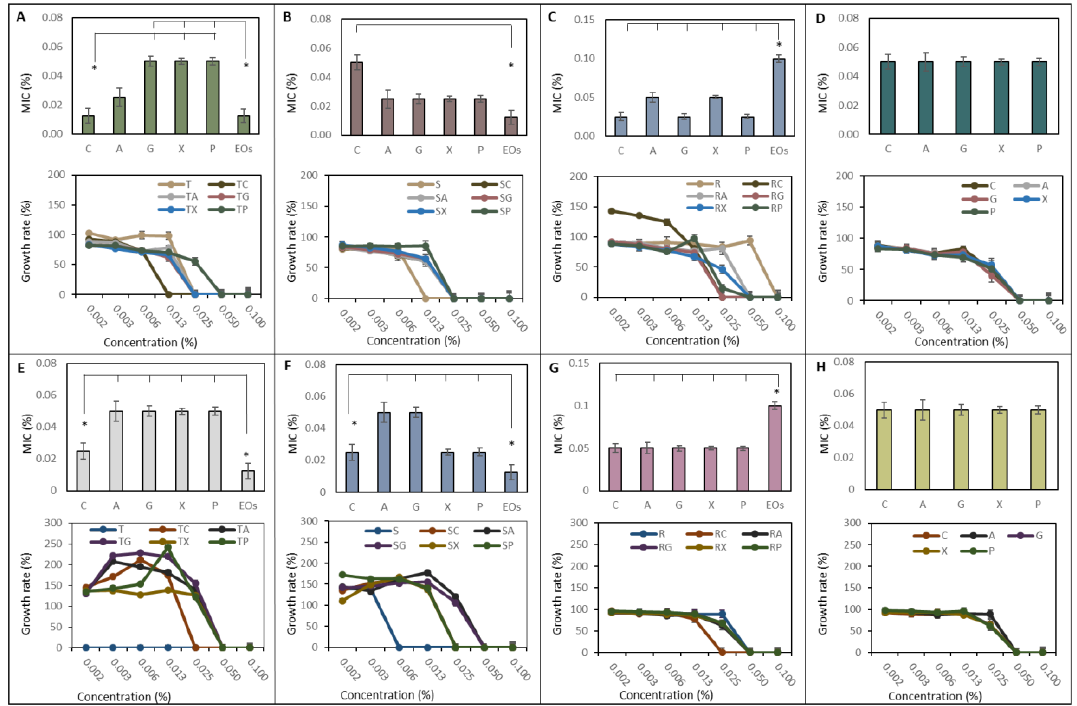
Figure 4. Inhibition activity of NCaps (C-C, A-C, G-C, X-C, P-CS and EOs (0.002–0.1% v/v )). The inhibition effect on S. aureus : ( A ) T-EOs, ( B ) S-EOs, ( C ) R-EOs and ( D ) NCaps alone. The inhibition effect on E. coli : ( E ) T-EOs, ( F ) S-EOs, ( G ) R-EOs and ( H ) NCaps alone. The minimal inhibition concentration (MIC) is shown on the top, and growth rate is shown at the bottom. Results are expressed as an average of three measurements n = 3. The asterisks indicate a difference in the significance level p < 0.05.